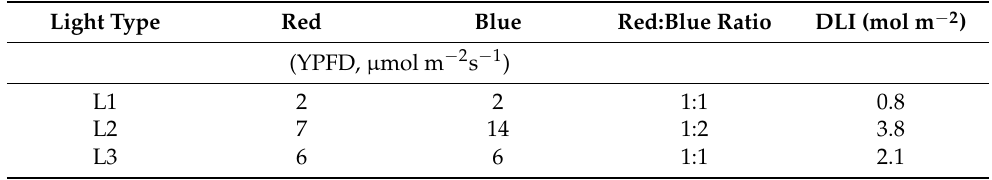
Table 3. Red and blue yield photon flux densities (YPFD, μmol m −2 s −1 ) and photon ratios of differ- ent types of lights.